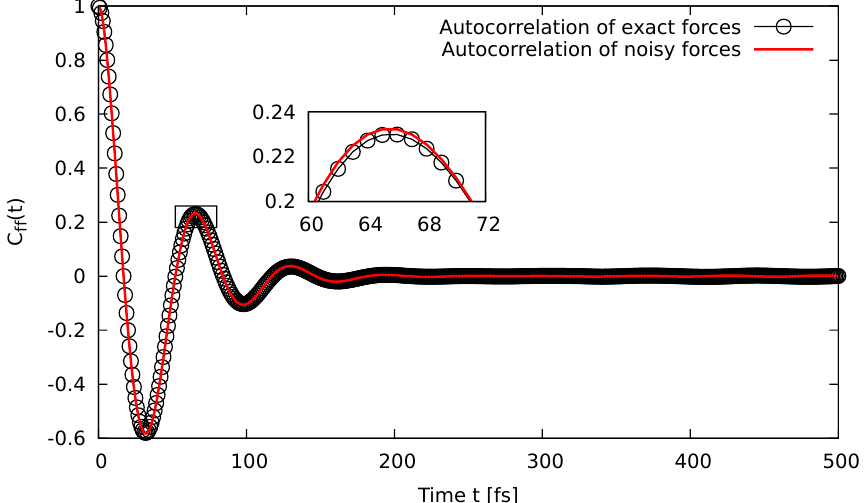
(cid:10) ( 0 ) F N ( t ) (cid:11) (line), which are compared to the F N I I